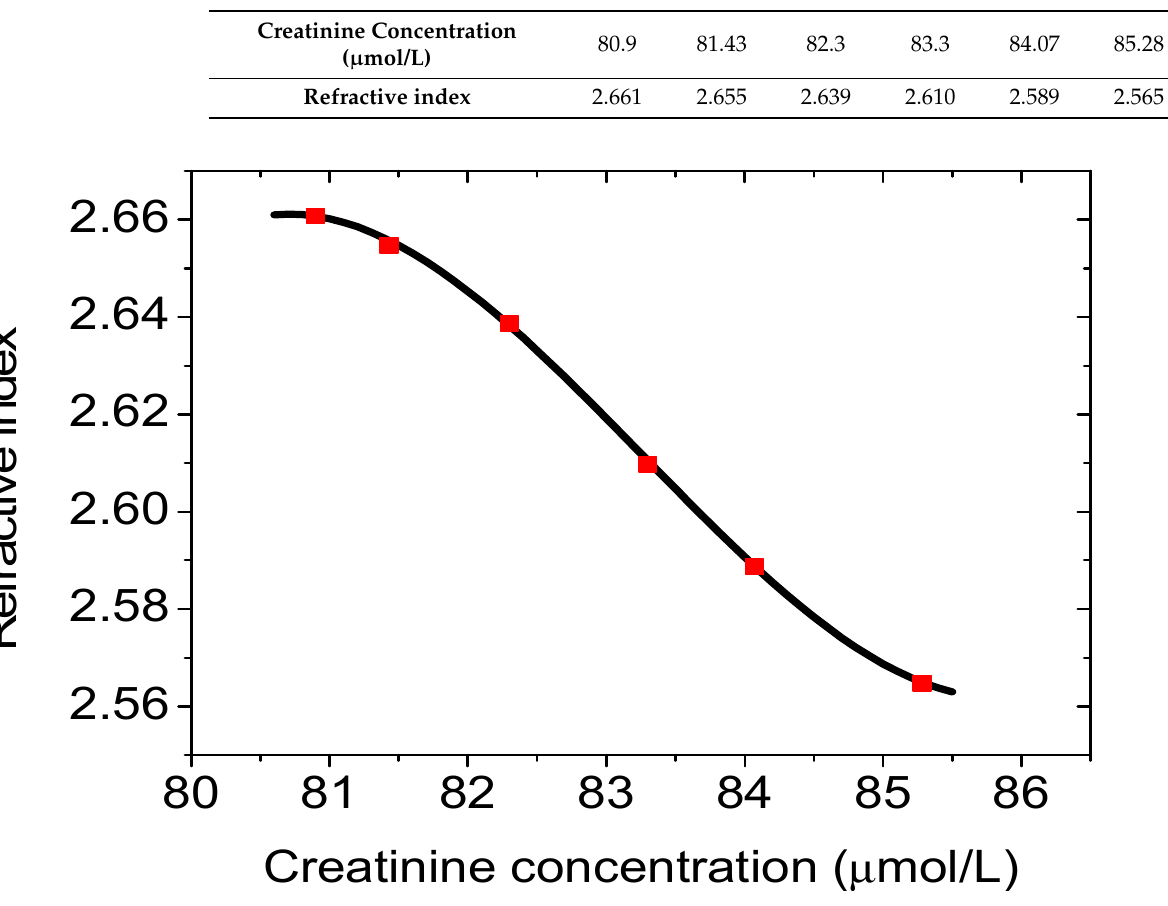
Figure 2. Index of refraction of the blood sample versus the creatinine concentration in μ mol/L.